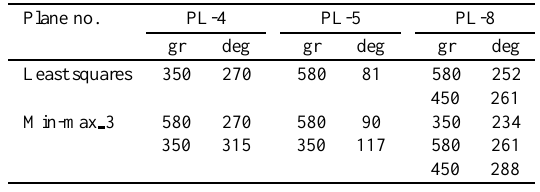
Table 7 Comparison of weights distribution for the nuclear turbine